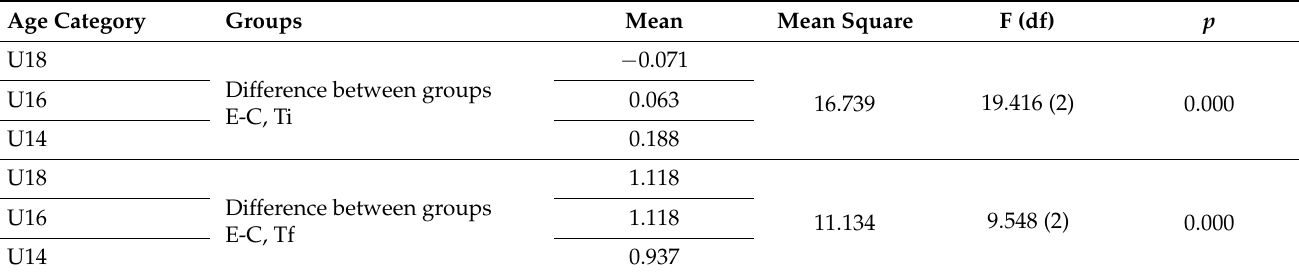
Table 6. ANOVA variance analysis between U14, U16, and U18 for the Shoot-Run